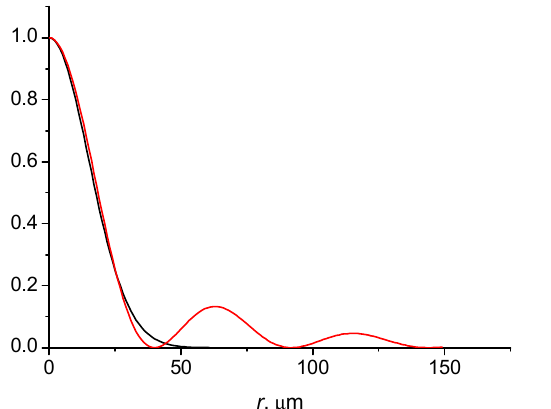
Figure 5. Intensity profiles of Gaussian (black line) and BG (red line) beams. a 0 = 30 µ m, w 0 = 200 µ m, w B = 40 µ